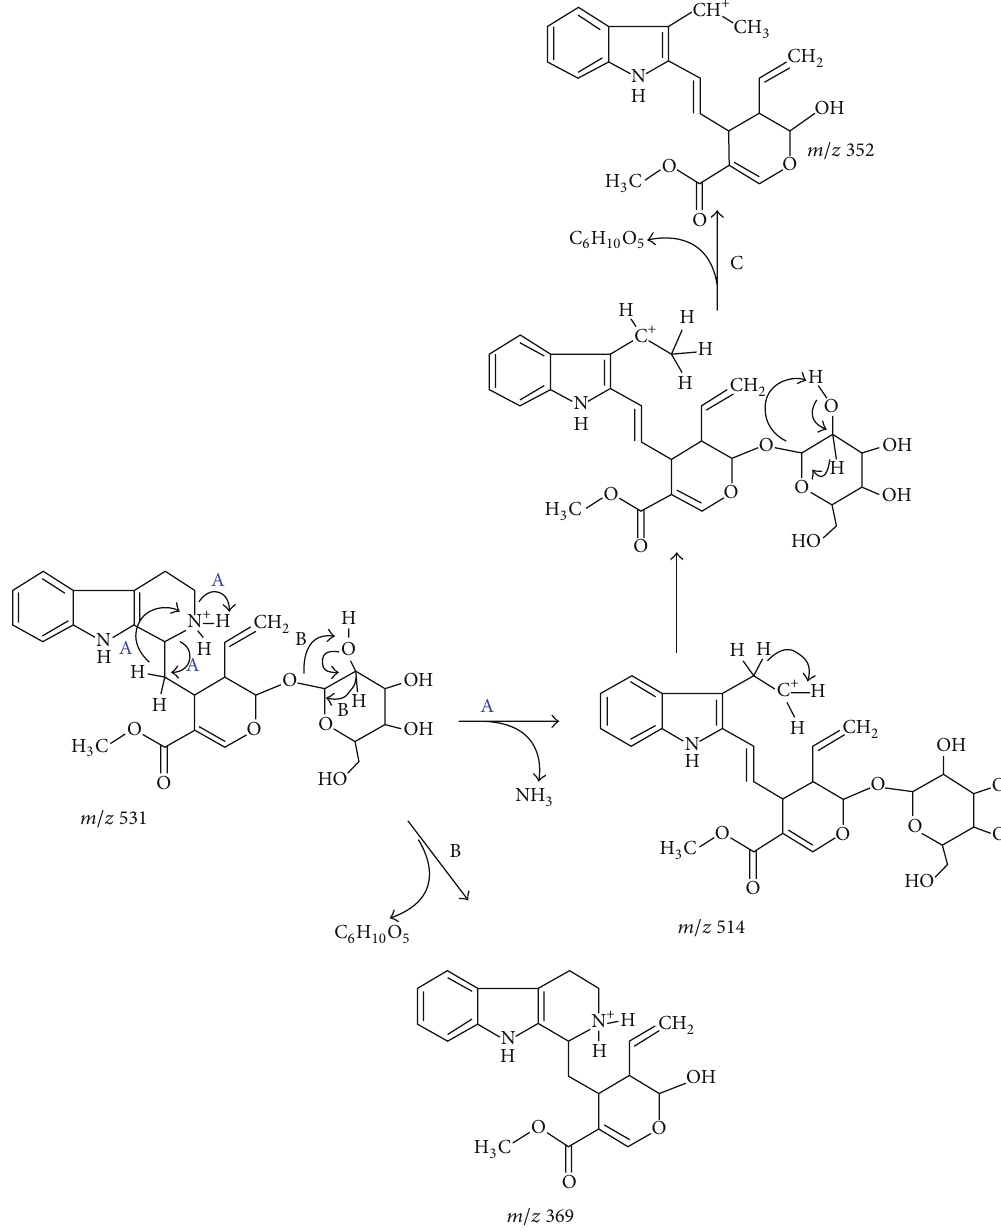
Figure 5: Mechanism proposed for the major fragmentation pathways of protonated